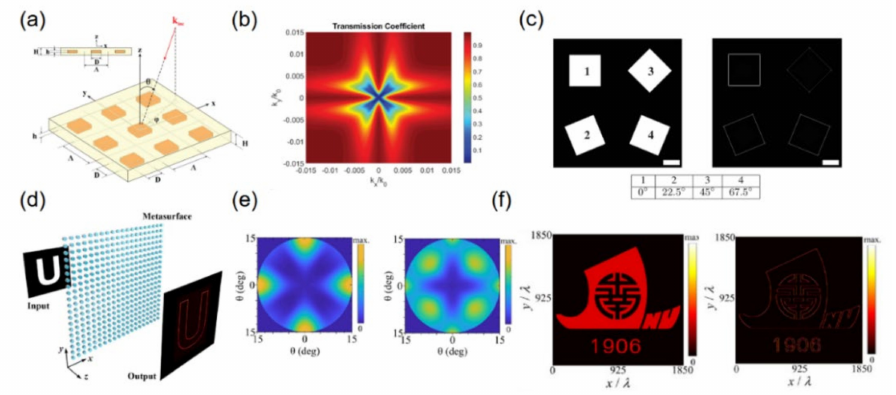
Figure 6. ( a ) Schematic of the square patch-arrays metasurface for 2D edge detection; ( b ) 2D spatial transfer function spectrum; ( c ) edge detection of square-shaped input beams; adapted with per- mission from [143], IEEE, 2018. ( d ) Schematic of the basic configuration of dielectric metasurface for 2D spatial differentiation; ( e ) the transfer functions for or both linearly polarized light fields; ( f ) the output image of 2D edge detection for x polarization light waves. Adapted with permission from [141] © The Optical